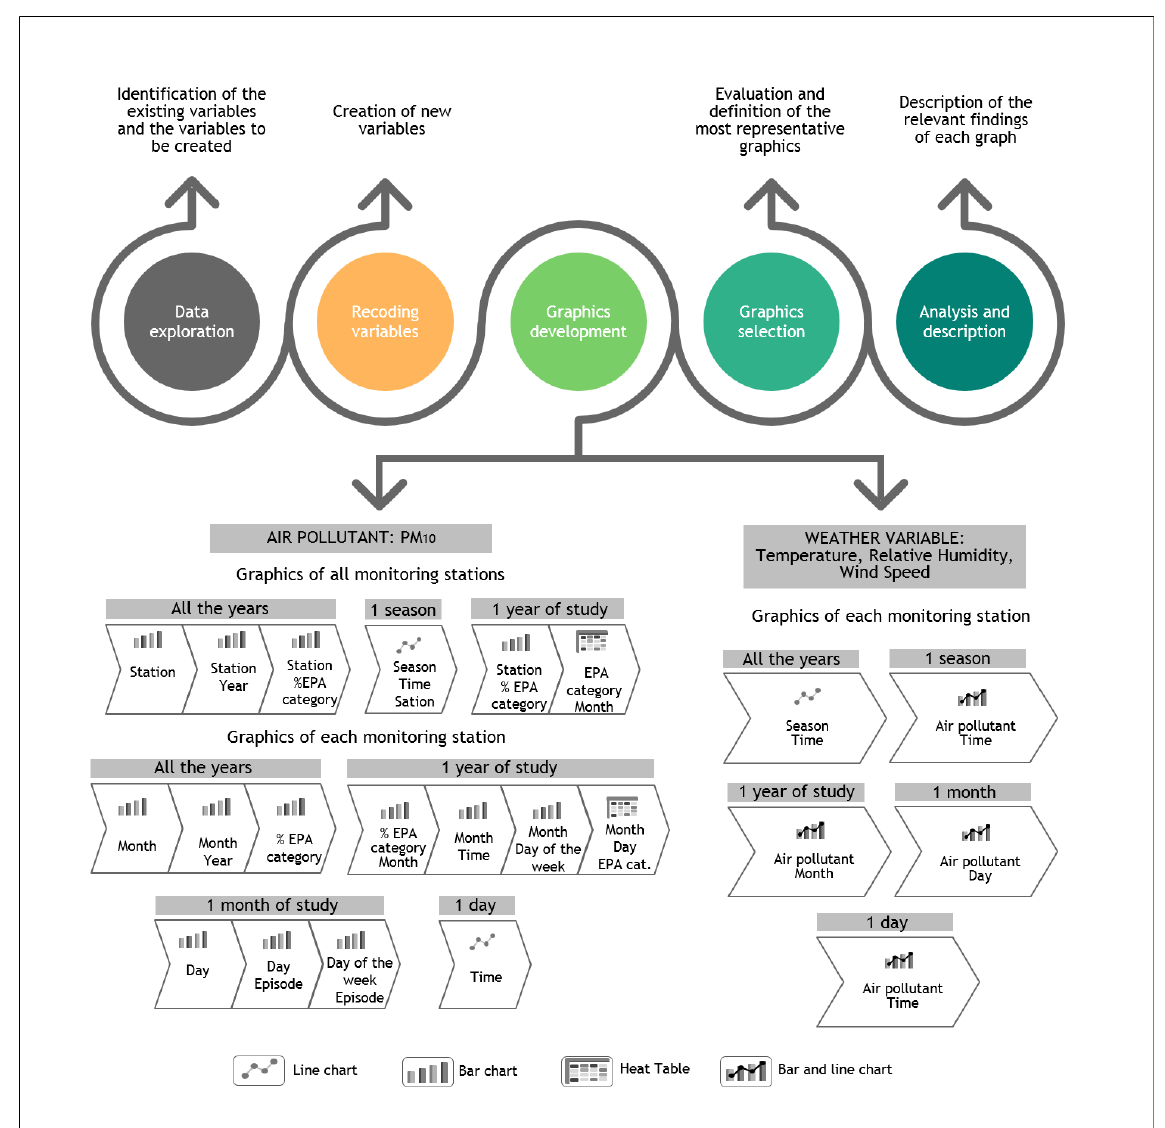
Figure 2. Proposal for a preliminary analysis of the data visualization from the air quality monitoring stations in Metropolitan Lima. The proposal is developed in five steps that range from the exploration of the data to the analysis and description of the